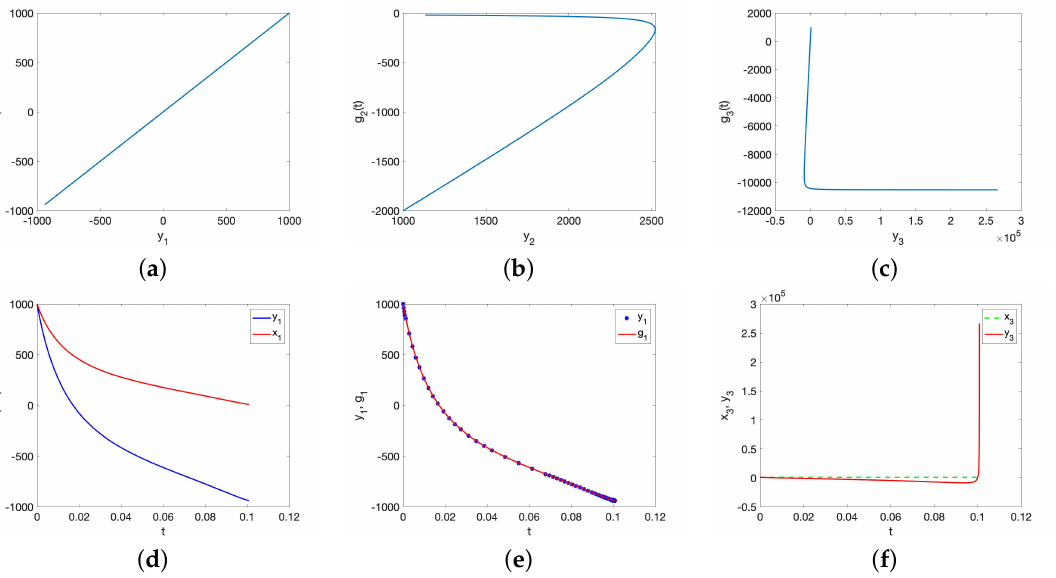
Figure 9. No synchronization for modified UR model and HP model with initial data [ x ( 0 ) , x ( 0 ) , x ( 0 )] = [ 1000,1000,1000 ] and [ y 2 3 1 plot showing 1:1 correlation. ( b ) y 2 − g 2 plot showing no 1:1 correlation. ( c ) y 3 − g 3 plot showing no 1:1 correlation. ( d ) Simulation showing time evolution for x 1 − y 1 . ( e ) Time series plot for y 1 − g 1 . ( f ) Time series plot showing blow-up occurring in y 3 and estimated at time T ∗ ≈